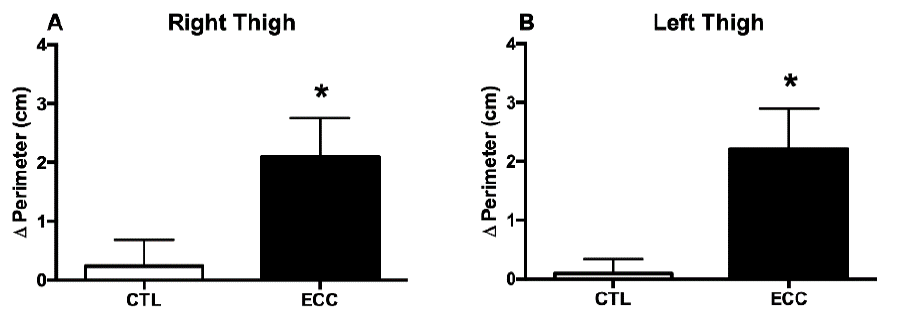
Figure 4. Comparison of the changes (Post-Pre) in thigh perimeter measurements between both lower limbs (cm) after training between CTL and ECC. Right thigh perimeter and Left thigh perimeter. * p <0.05. Results are shown as mean